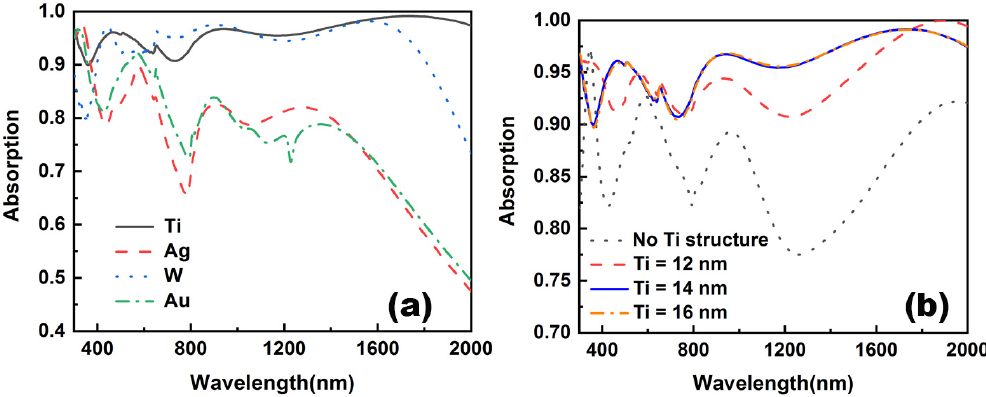
Figure 9. Absorption spectra of different cases of Ti layers. ( a ) Comparison of absorption spectra of different metals. ( b ) Comparison of absorption spectra of different Ti thicknesses.